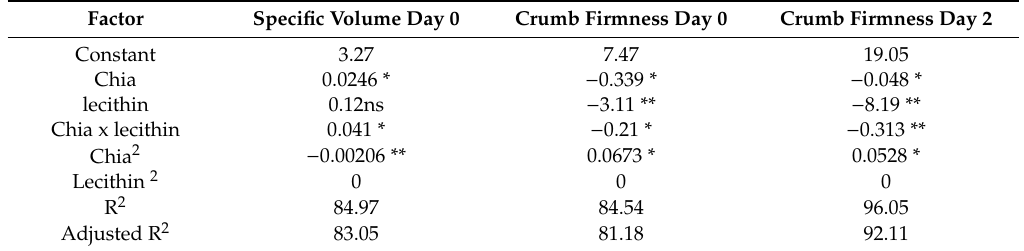
Table 4. Regression coe ffi cients and analysis of variance of the quadratic regression fitting models.